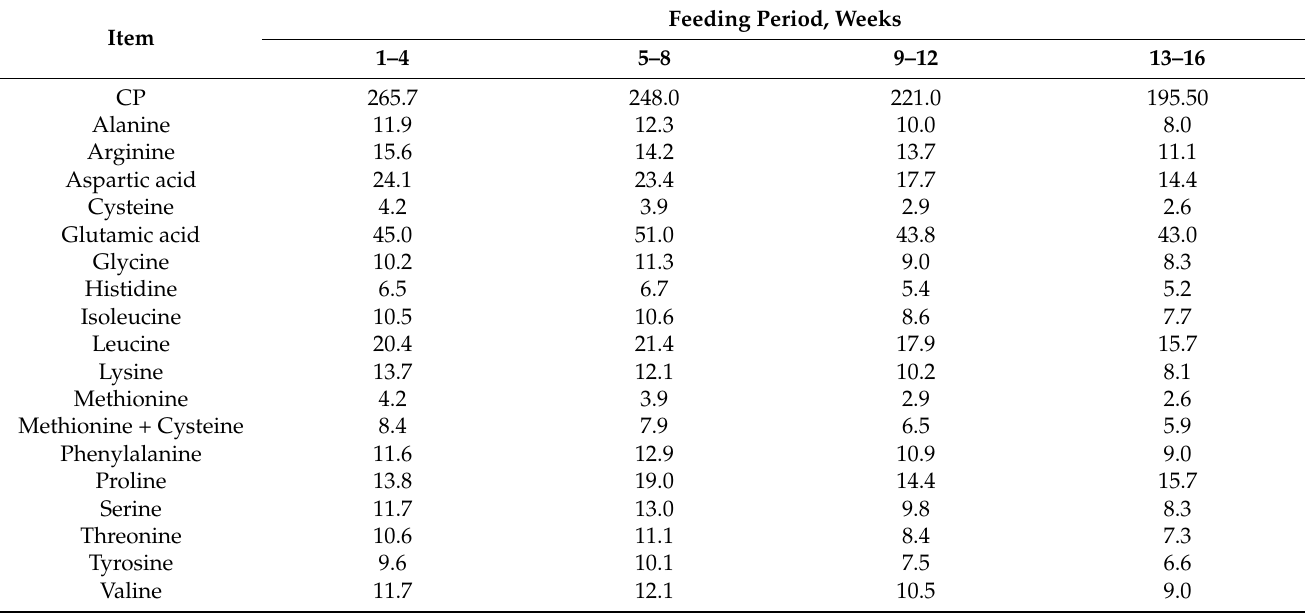
Table 4. Amino acid content (g/kg) of basal diets of turkeys, Experiment 2 1